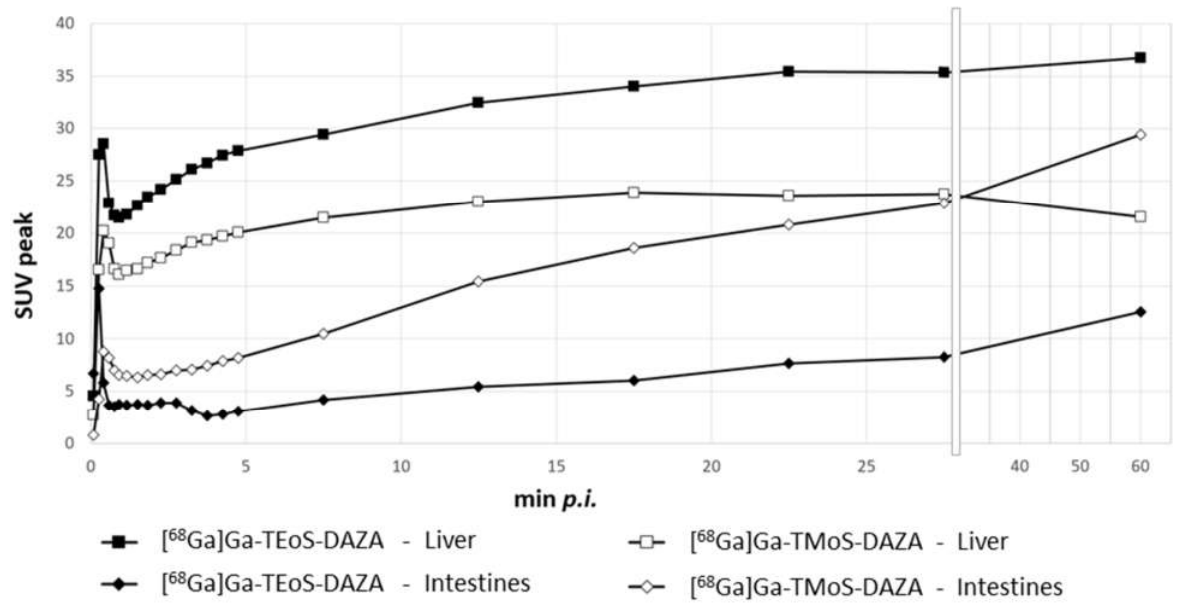
Figure 8. SUVpeak in the liver and the intestines for both 68 Ga-tracers, respectively, given as the mean ( n = 7). Error bars are omitted for clarity. From the 28th minute onwards, the x axis is com- pressed.